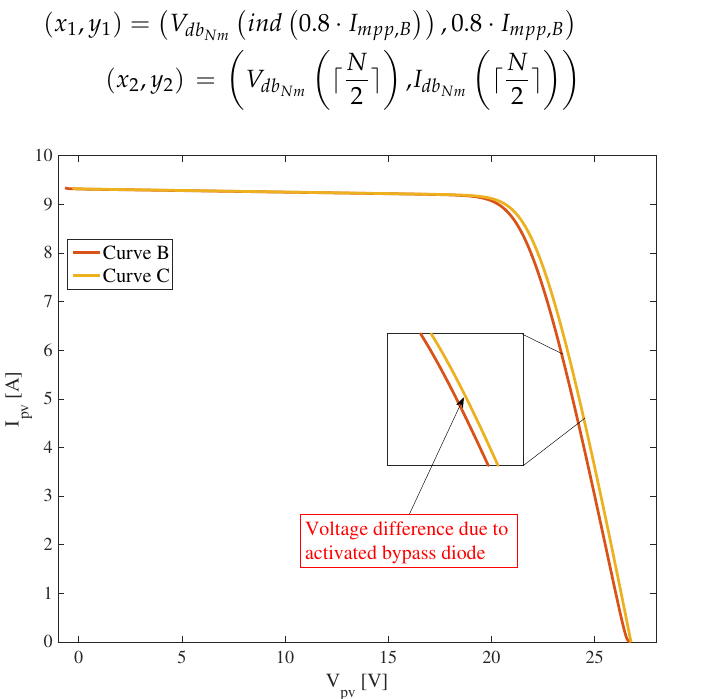
Figure 6. Voltage difference between curves B (red line) and C (yellow line) introduced by the active bypass diode of the completely shaded